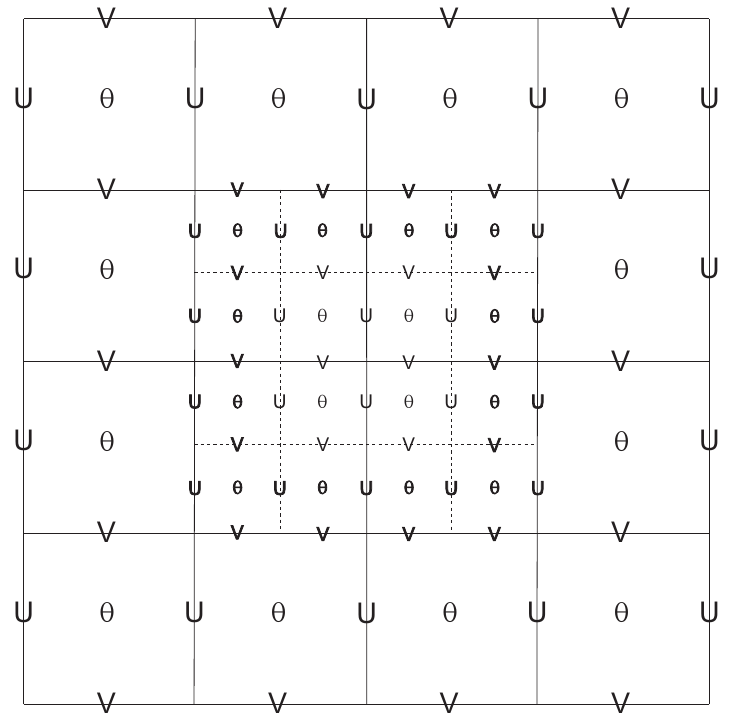
Figure 7.4: Similar to Fig. 7.3, but with a 2:1 grid-distance